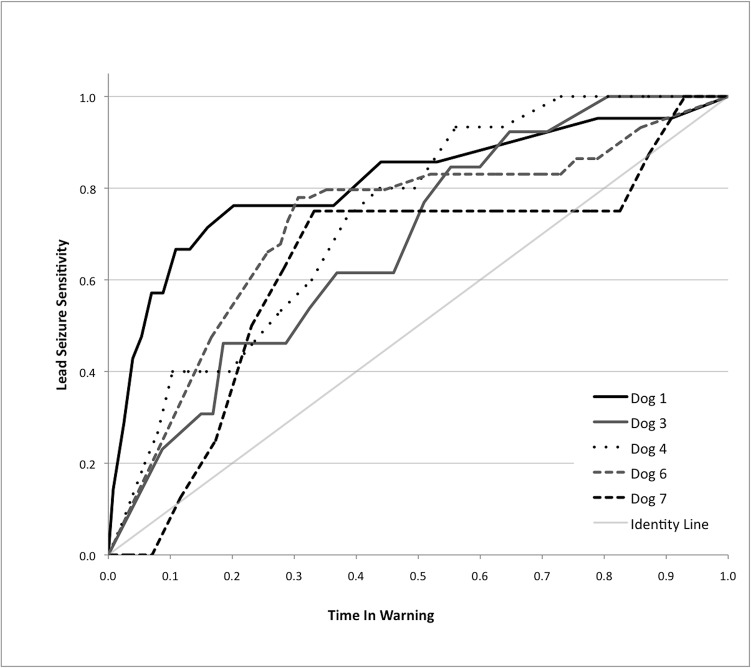
Receiver-operating characteristic curves for the five analyzed canines.Curves were generated by varying the threshold required to initiate a seizure warning.